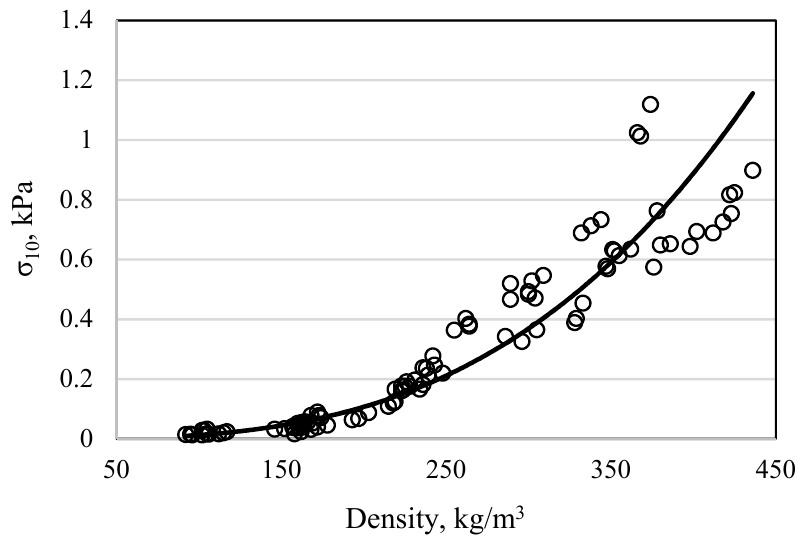
Figure 8. Dependence of the compressive stress of the biocomposite at 10% deformation on its den- sity.